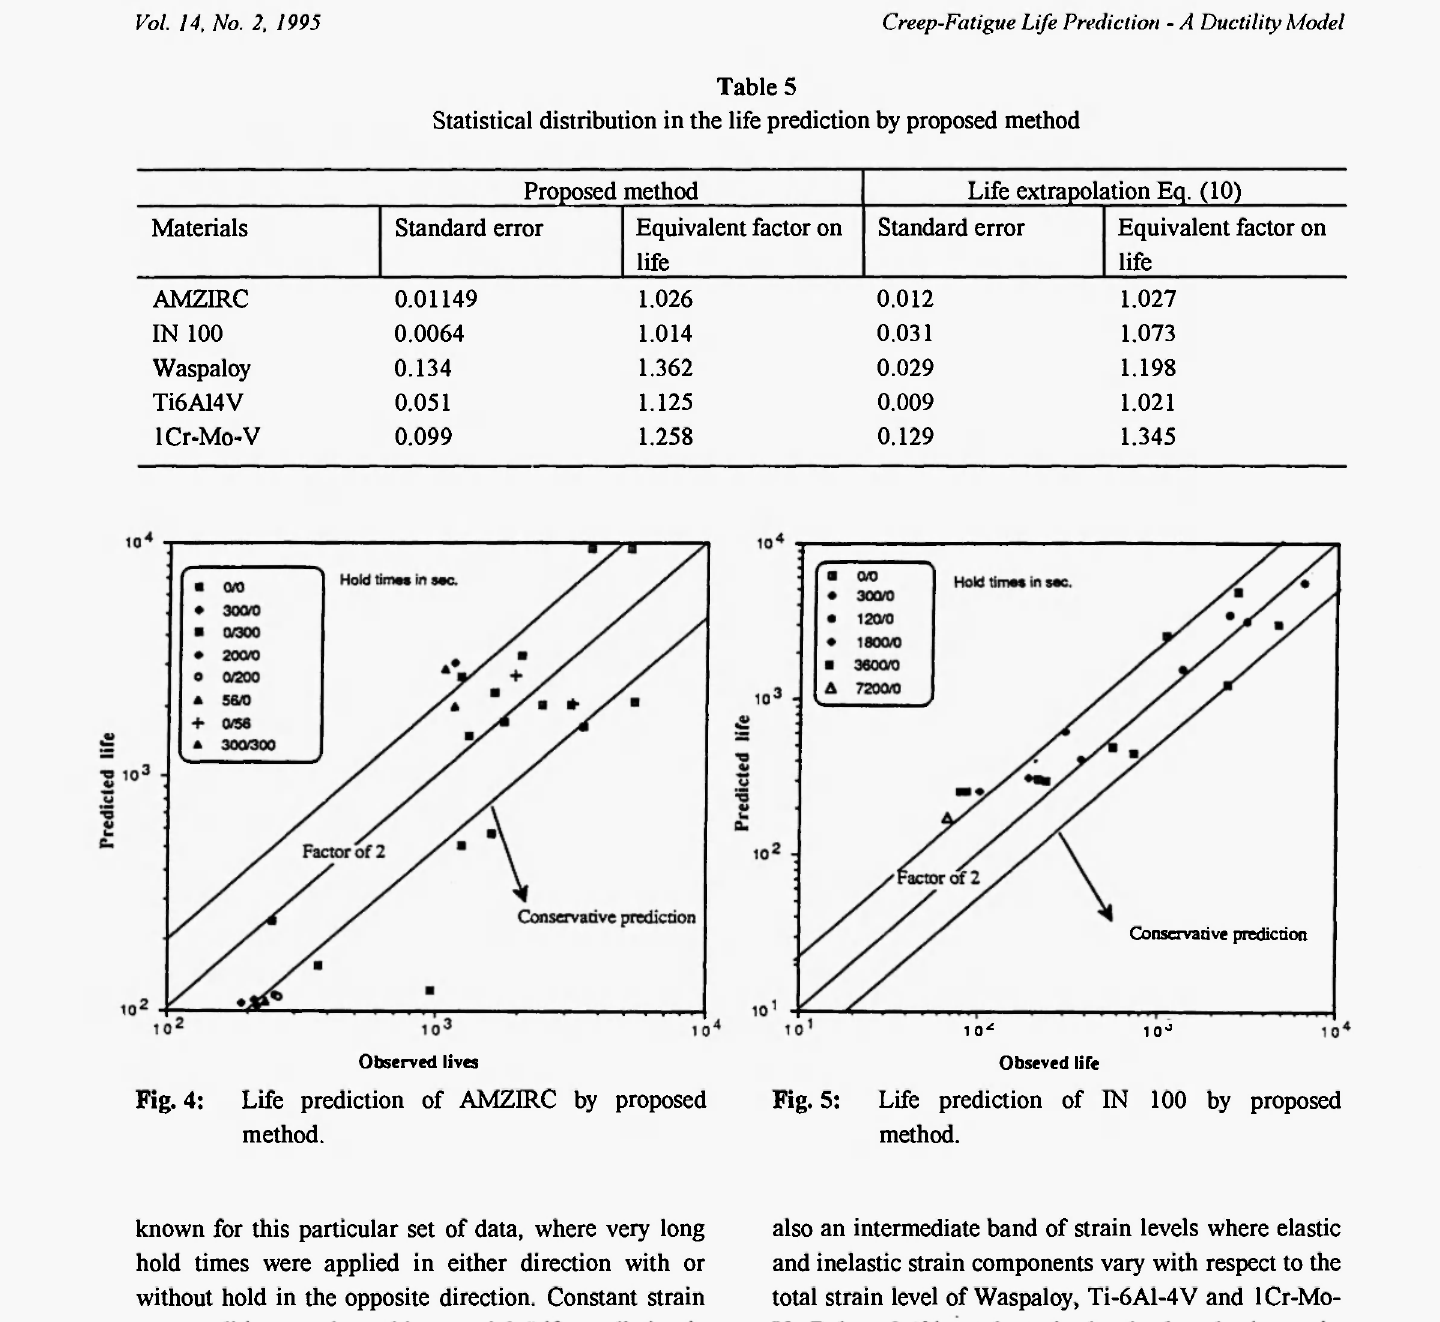
Fig. 4: Life prediction of AMZIRC by proposed method.